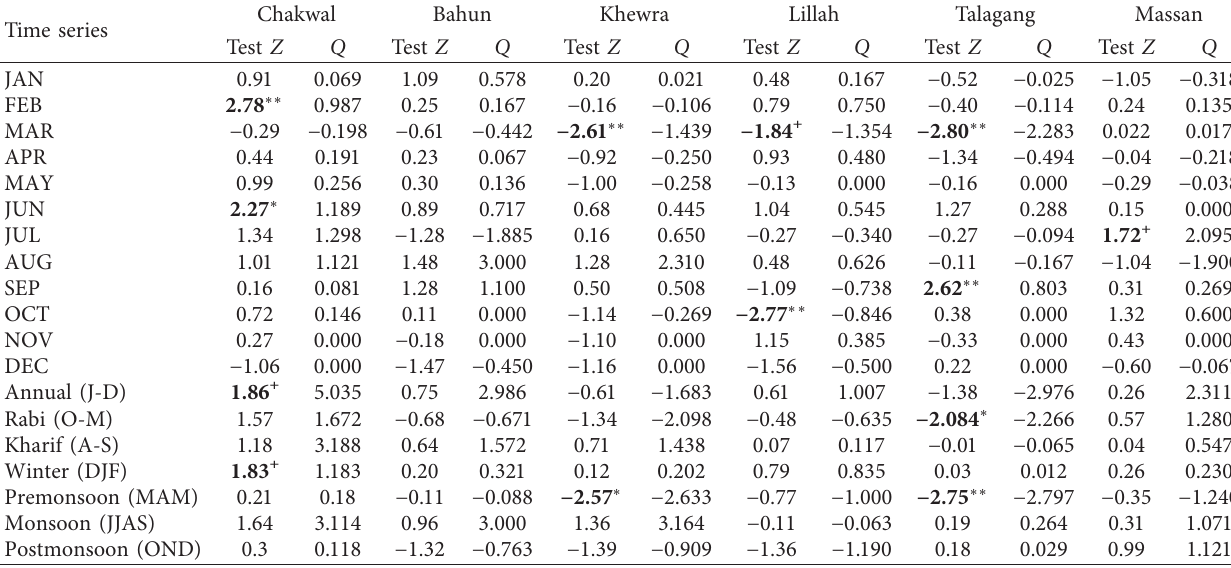
Table 5: Monthly, seasonal, and annual rainfall statistic in zone-3 stations using Mann–Kendall test and Sen’s slope estimate. Time series